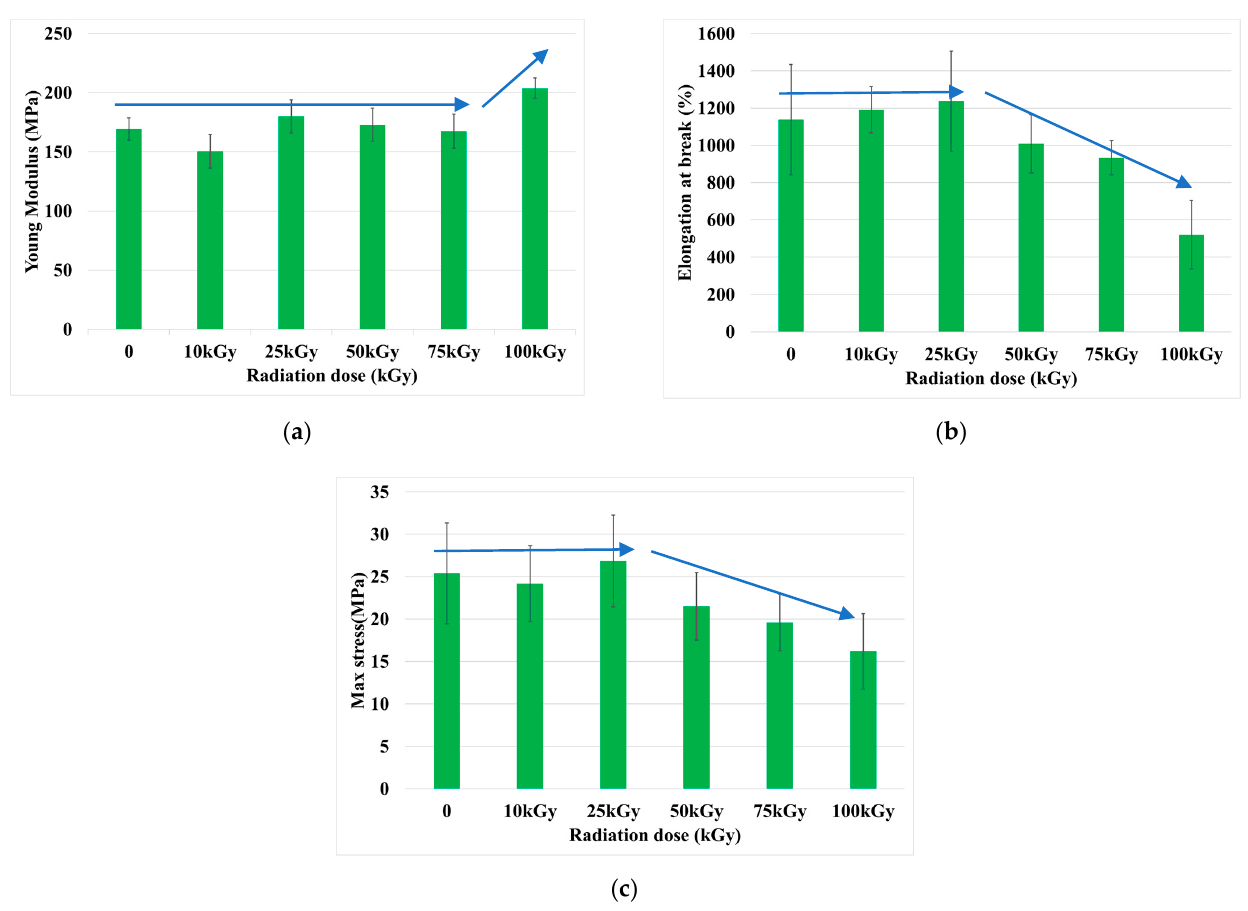
Figure 5. Influence of EB radiation dose on 3D-printed PCL specimens: ( a ) Young’s Modulus, ( b ) elongation at break, ( c ) max stress.